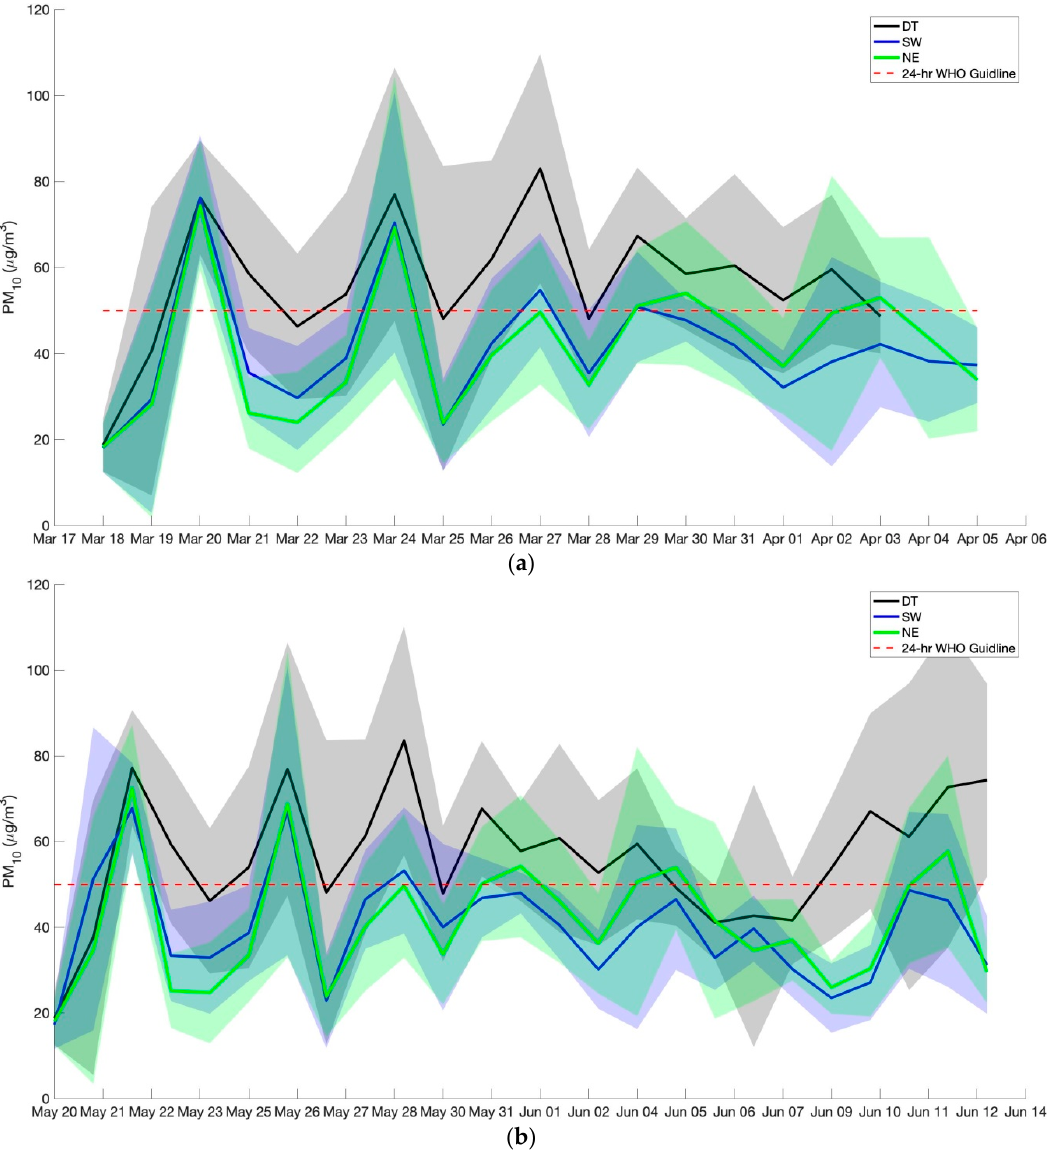
Figure 6. Daily average of concentrations of particulate matter less than 2.5 µm in aerodynamic diameter (PM 10 ) in the three locations—DT, SW, NE—compared to WHO guidelines ( a ) during the March–April period; ( b ) during the May–June period. (The shaded areas represent the standard deviations).